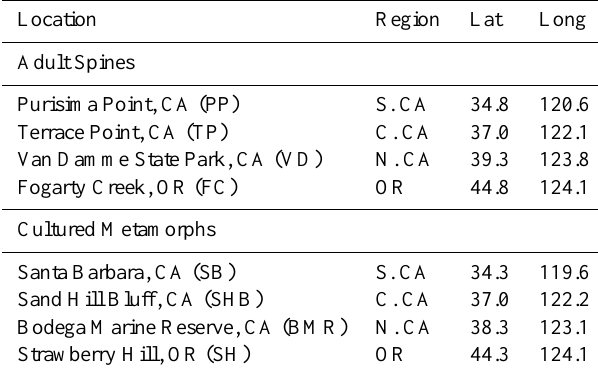
Table 1. Sampling locations and coordinates for eight urchin popu-